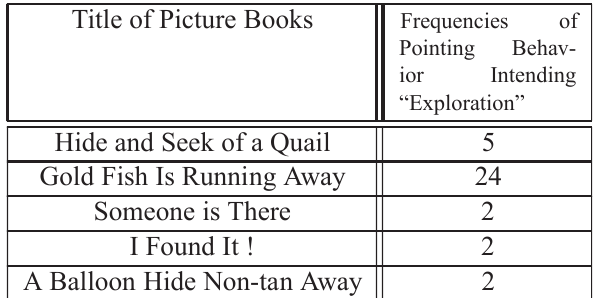
Table 3. The Picture Books Stimulating Pointing Behavior In- tending